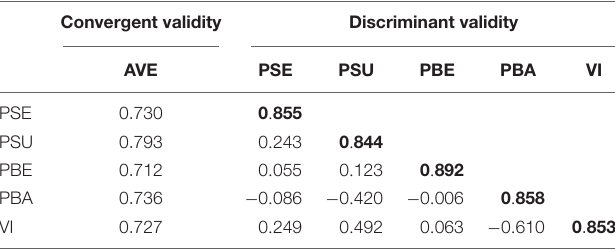
TABLE 2 | The convergent validity and reliability of the reflective scales. Constructs